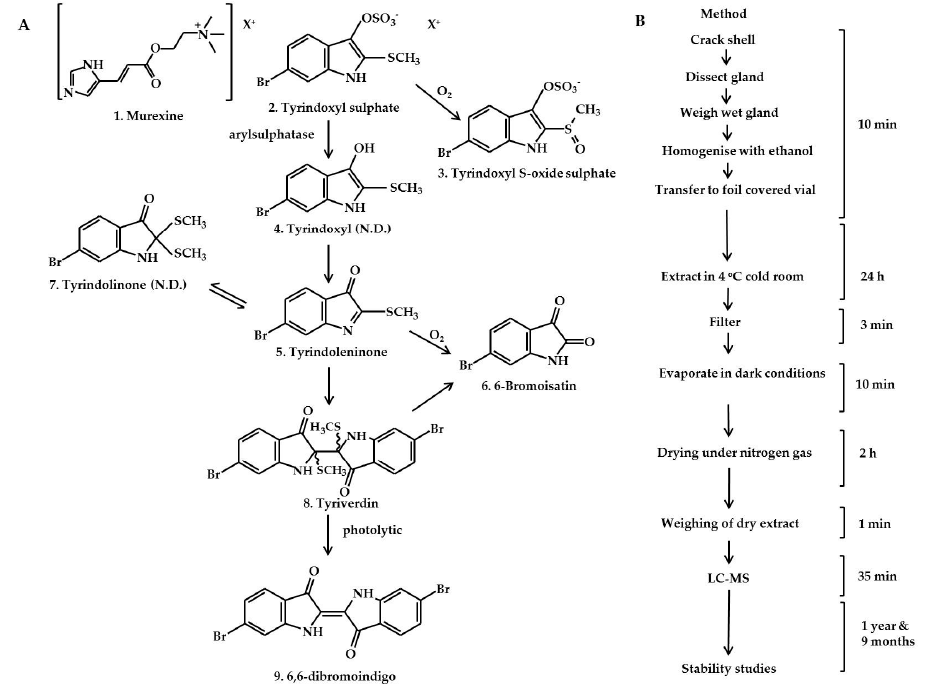
Figure 1. Extraction of precursors and generation pathway of Tyrian purple detected by LC-MS from the hypobranchial gland of D. orbita : ( A ) Reaction scheme for generation of Tyrian purple from precursors and ( B ) the extraction procedure showing the time spent for each step in the preparation of extract. N.D.—not detected.